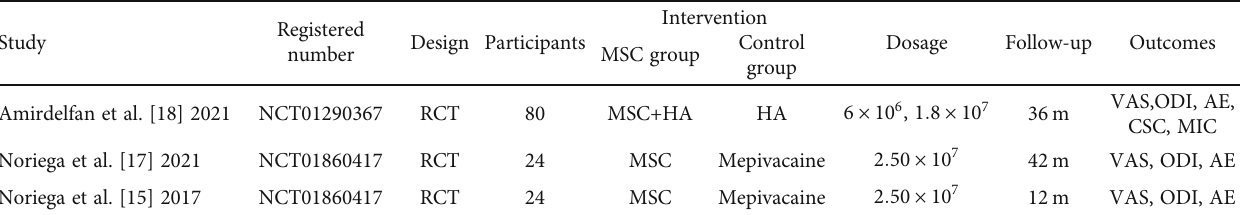
Table 1: Characteristics of each study.